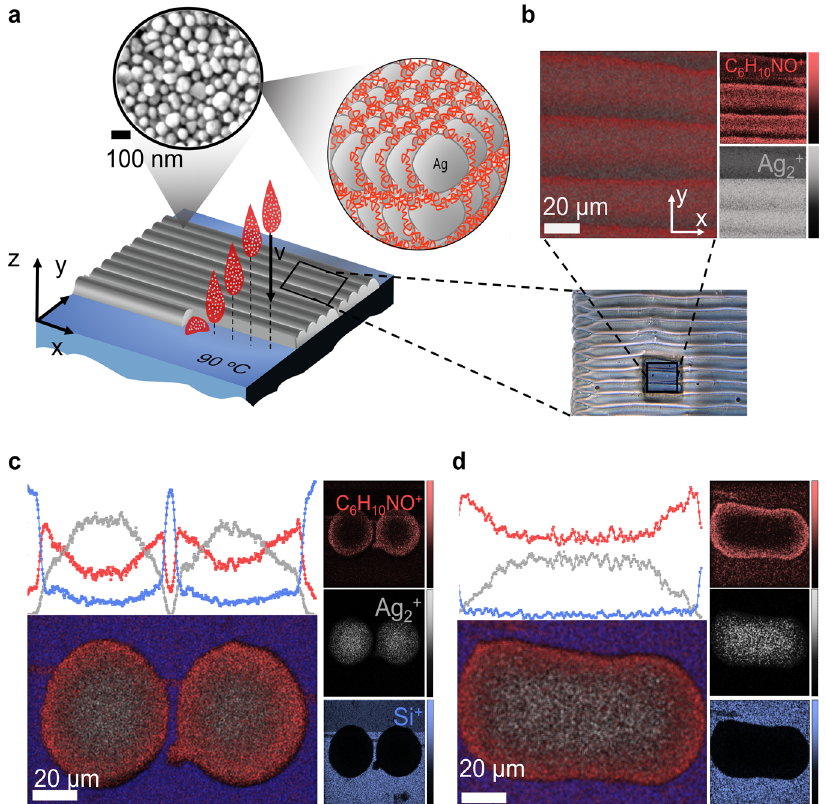
Fig. 1 inkjet printing AgNPs and detection of polymer stabiliser. a Drop-on-demand jetting of inks containing AgNPs with in situ solvent evaporation (pinning). The AgNPs size distribution of the ink is detailed in Supplementary Fig. 3. b Optical image (bottom) of a printed layer of AgNPs and chemical maps (top) showing the distribution of Ag 2 + (grey), C 6 H 10 NO + (red), and Si + (blue) at the surface of a printed layer, c pair of deposited droplets and d two coalesced droplets. The line plots represent the intensity across the centre of each